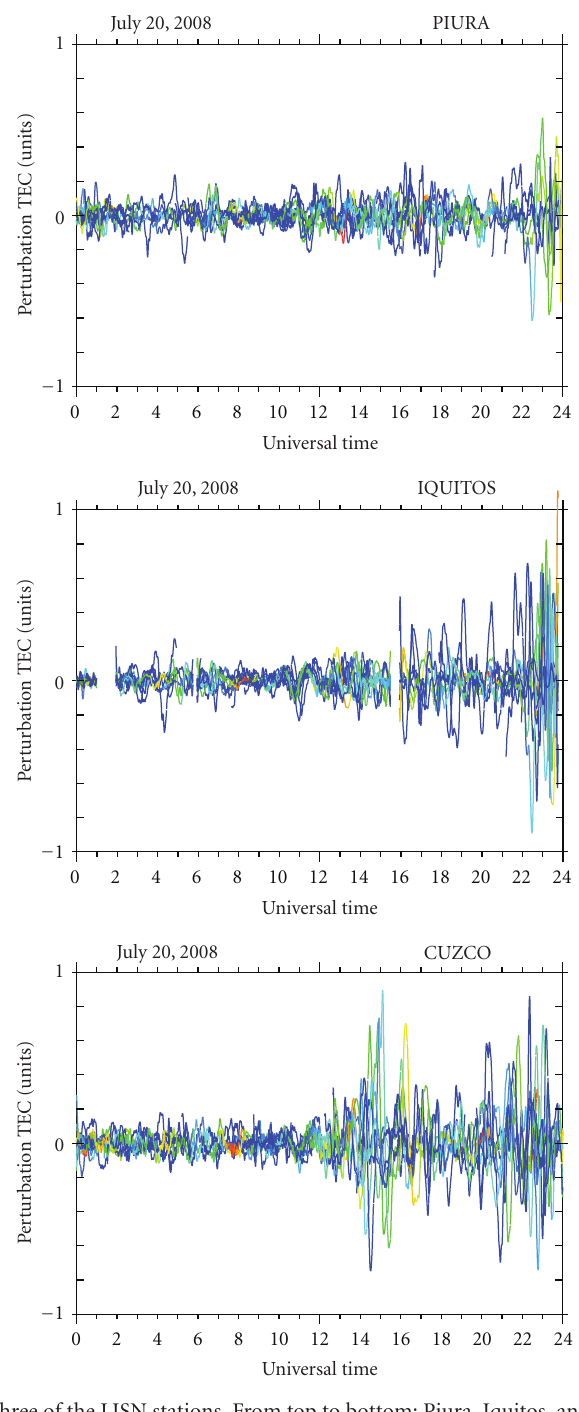
Figure 8: Same as Figure 3, but for three of the LISN stations. From top to bottom: Piura, Iquitos, and Cuzco. These TECP values were ob- tained on July 20,